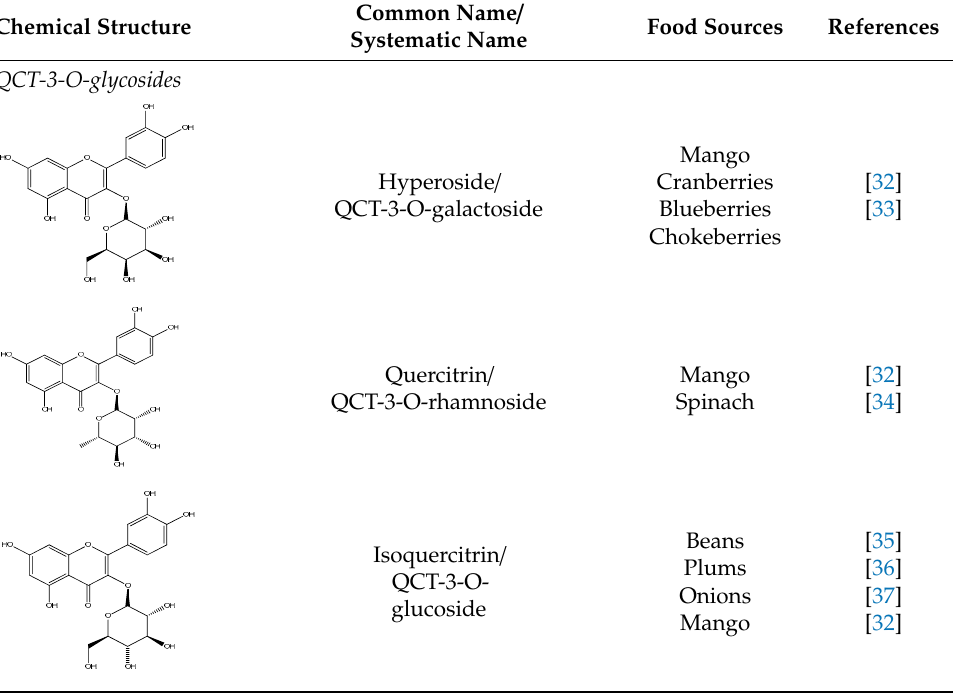
Table 1. Overview of QCT derivatives, chemical structures and natural sources.